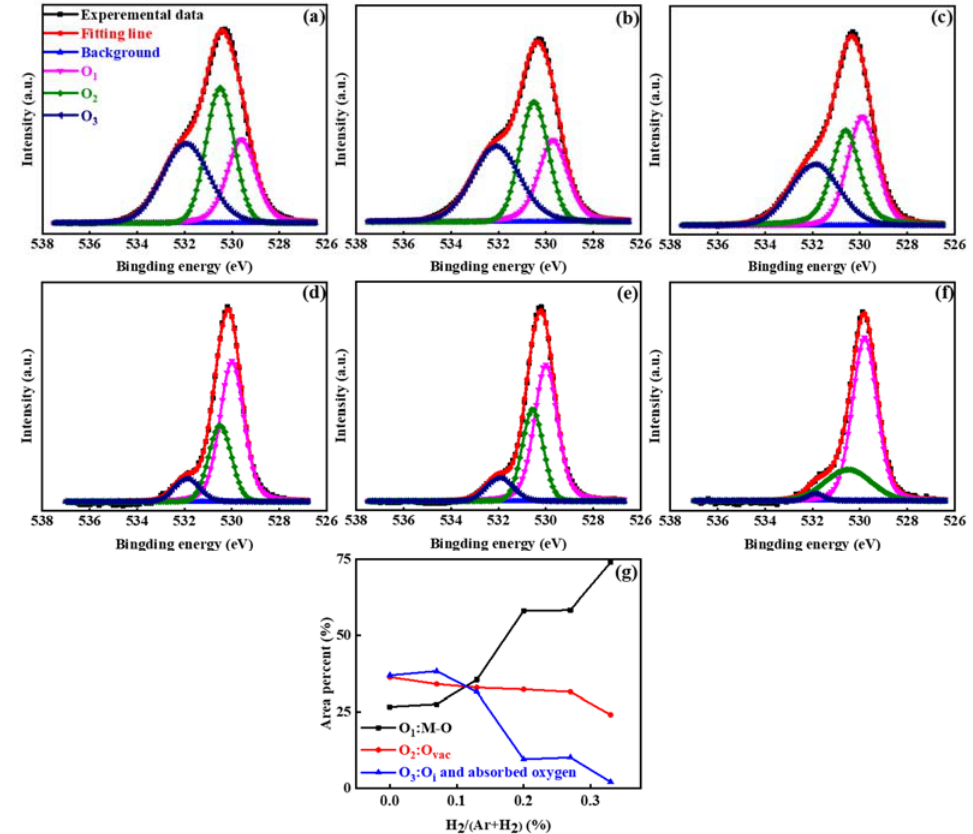
Figure 4. XPS spectra of O 1s with different H 2 /(Ar + H 2 ): ( a ) 0%, ( b ) 0.07%, ( c ) 0.13%, ( d ) 0.20%, ( e ) 0.27%, ( f ) 0.33%; ( g ) the proportion variation of three oxygen components with H 2 flow ratio. The output curves of our devices fabricated with different H 2 flow ratios are shown in Figure 5. All the devices exhibit n ‐ type TFT output characteristics without any current crowding, reflecting good ohmic contact between the active layers and the source/drain electrodes. The output curves of all ZnO:H/ZnO ‐ TFTs show obvious pinch ‐ off and source ‐ drain current saturation, indicating that the devices have good switching characteristics and reach the saturation mode under test conditions. Compared with the undoped device, all H ‐ doped devices exhibit higher I on . With increasing H 2 /(Ar + H 2 ), I on first increases and then decreases. When V DS = 30 V and V GS = 30 V, I on is 5.55 × 10 − 4 A for the undoped device; it reaches a maximum value of 1.81 × 10 − 3 A for the device with H 2 /(Ar + H 2 ) = 0.20%, more than three times higher than that of the former. Additionally, it decreases to 5.97 × 10 − 4 A for the device with H 2 /(Ar + H 2 ) = 0.33%, similar to that of the undoped device.